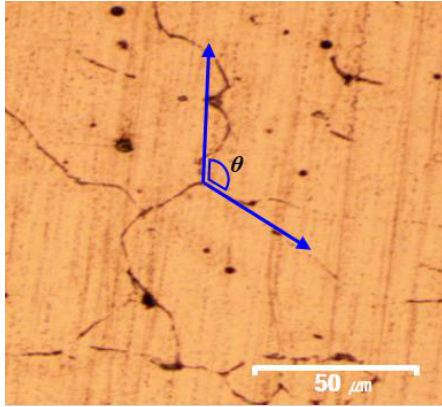
Figure 3. Schematic diagram of a mold for the Tatur test: (1) k-type thermocouple, (2) stopper, (3) pouring cup, (4) Tatur mold, (5) band heater, (6) heating controller, and (7) firebrick.